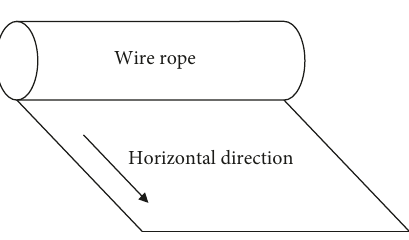
Figure 4: Circumferential